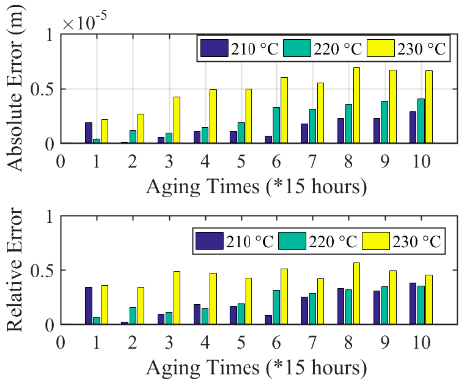
Figure 21. Errors between calculated and measured creep deformation under 210 ◦ C, 220 ◦ C, and 230 ◦ C.